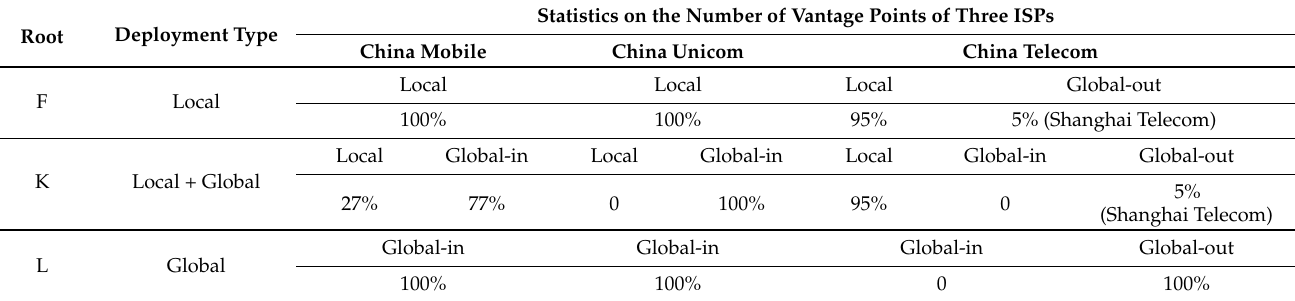
Table 4. Summary of access to the F root, K root, and L